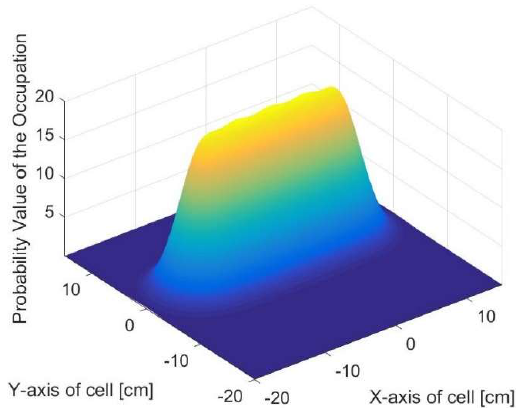
Figure 8. A part of the vehicle’s trajectory representation using Gaussian kernel.